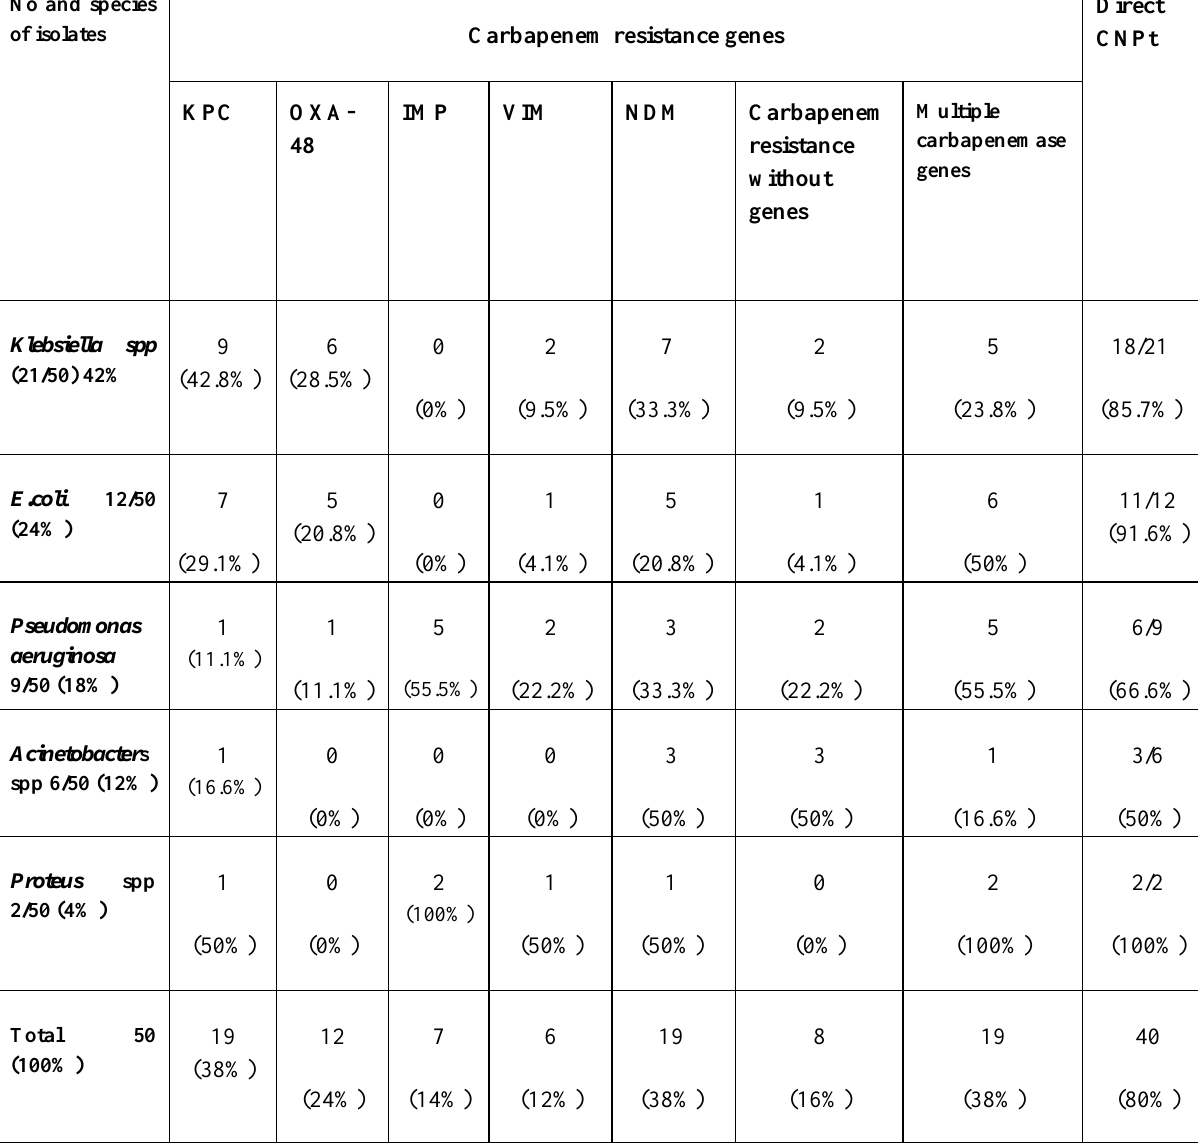
Table 2. Pattern of carbapenem resistance among Gram-negative bacilli. No and